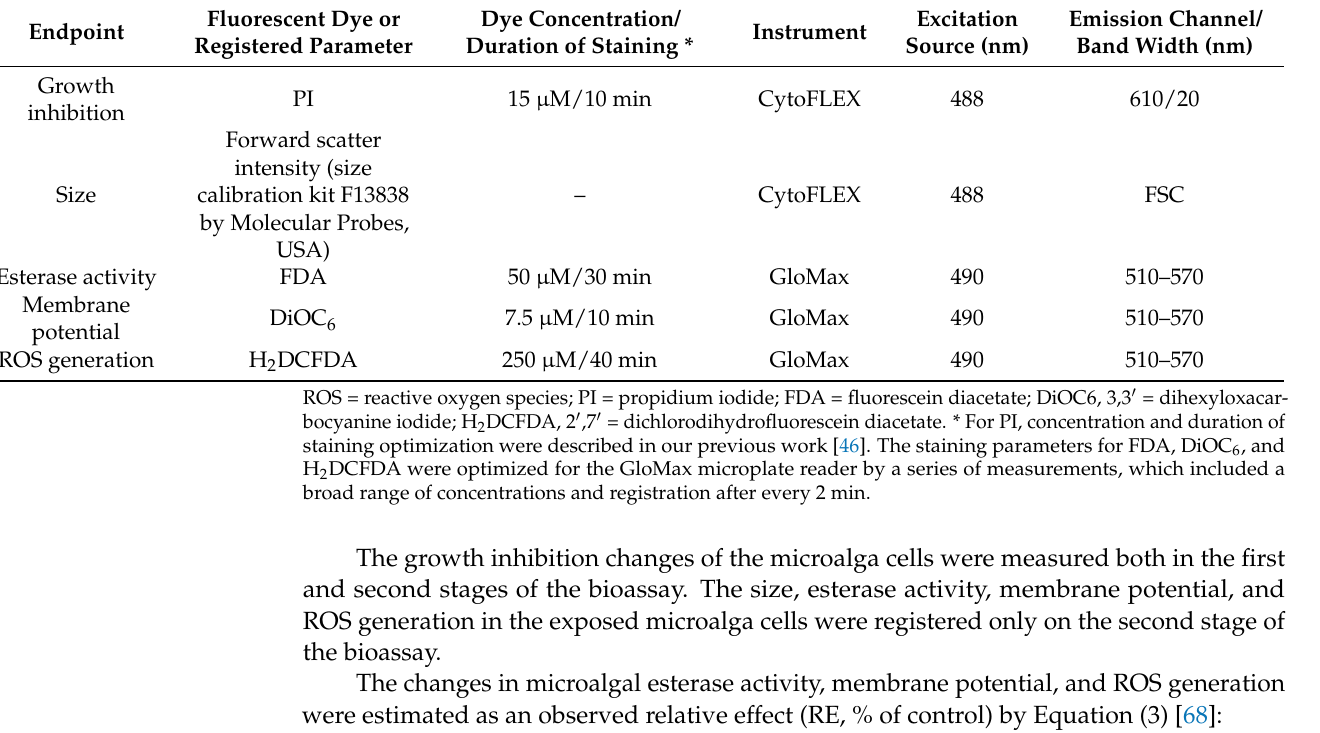
Table 6. Bioassay endpoints and registration